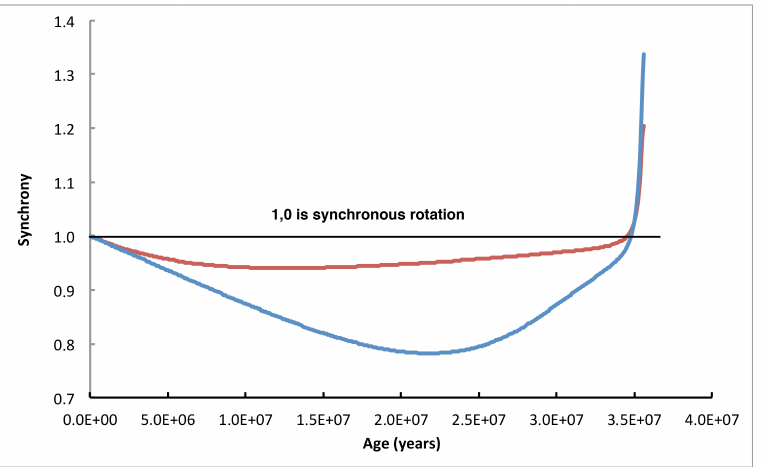
Figure 2. Deviation from synchronous rotation of a 8 M (cid:12) -primary caused by tidal interaction with its 3 M (cid:12) -companion. The blue line illustrates the action of the Darwin mechanism. The addition of the Tassoul mechanism to synchronization is shown by the red